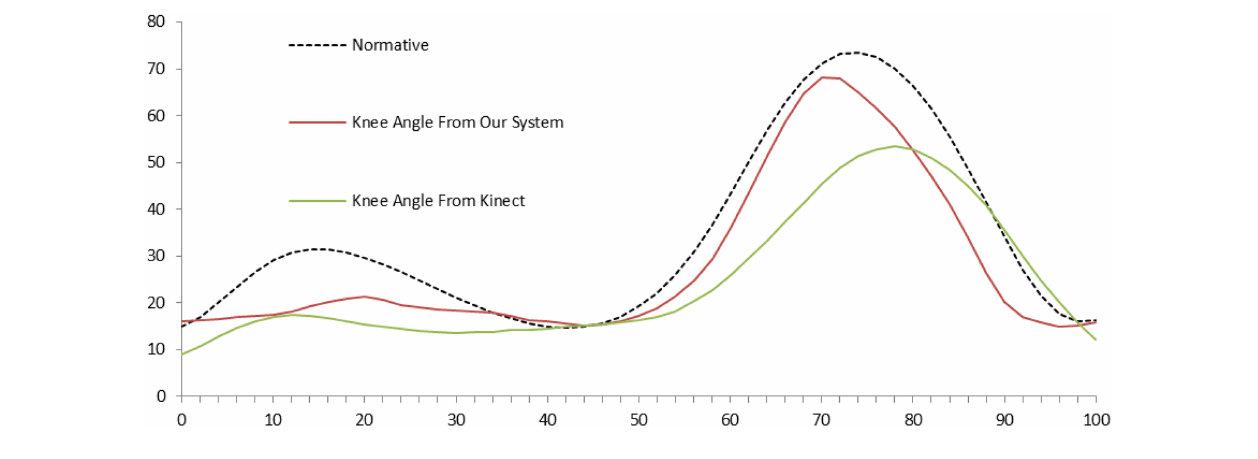
FIGURE 4 | Comparison of knee extension/flexion angle measured using OpenPose and Kinect.